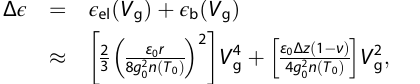
where ϵ el is the strain due to electrostatic pulling 30,53 , ϵ b the strain due to bending 54,55 , Δ z = z neut − z CGT the distance from the neutral plane of the heterostructure z neut to the central axis of CGT layer z CGT (see Supplementary Note 3), ε 0 the dielectric permittivity of vacuum, and n ( T 0 ) = 2.538 ± 0.003 N m − 1 the total tension in the suspended heterostructure at T 0 = 60 K (extracted from the fi t in Fig. 5e). Apart from the effect of electrostatically induced strain on f 0 ( V g ) in Fig. 5d, the characteristic feature in the f 0 ( T ) curve, that we attribute to the Curie temperature of CGT 27 , shifts to higher temperatures. This trend becomes even more apparent in Fig. 5f, for six different V g . We extract T (cid:3) from the peak where we plot d ð f 2 0 Þ C d T